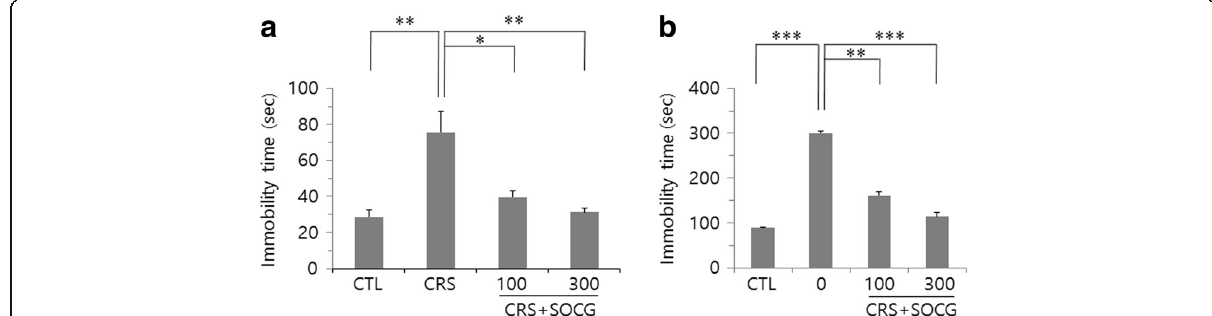
Fig. 6 Regulation of depressive-like behavior by SOCG administration in CRS animals. Animals in each experimental groups were subjected to FST ( a ) and subsequently by OFT ( b ) 24 h later. *P < 0.05, **P < 0.01, ***P < 0.001 (One-way ANOVA, n =